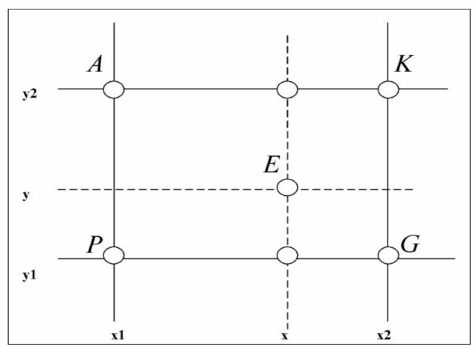
Figure 6. Nearest Neighbourhood grid where estimation in E is done regarding to points A, K, P or G (e.g.,